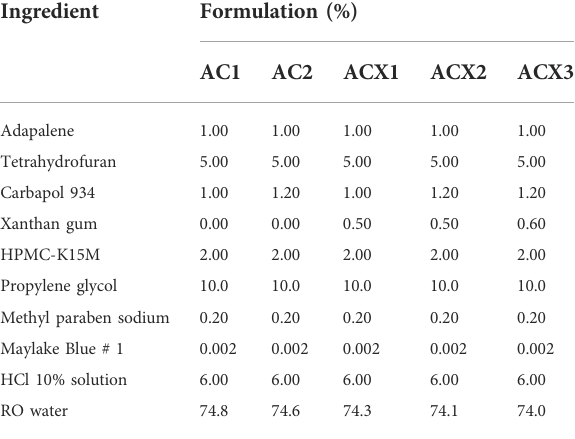
TABLE 1 Percentage composition of tested